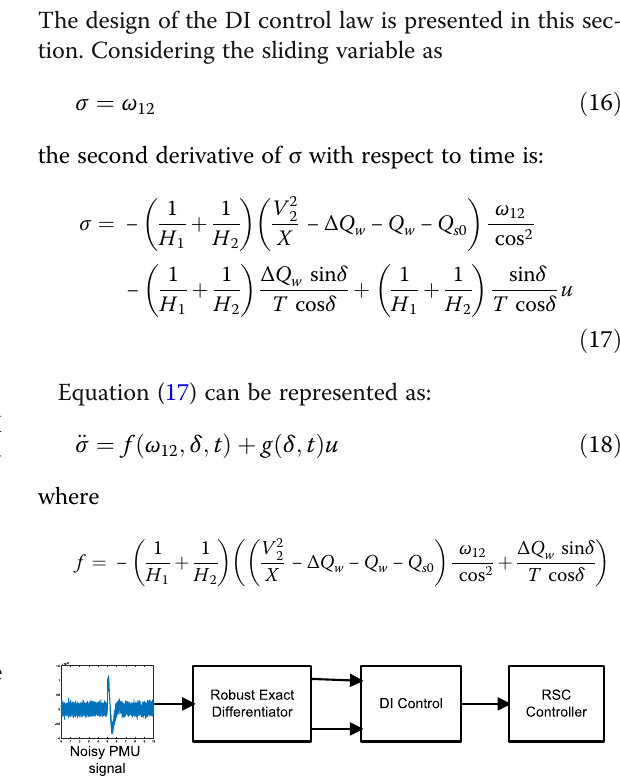
Fig. 4 Proposed Composite